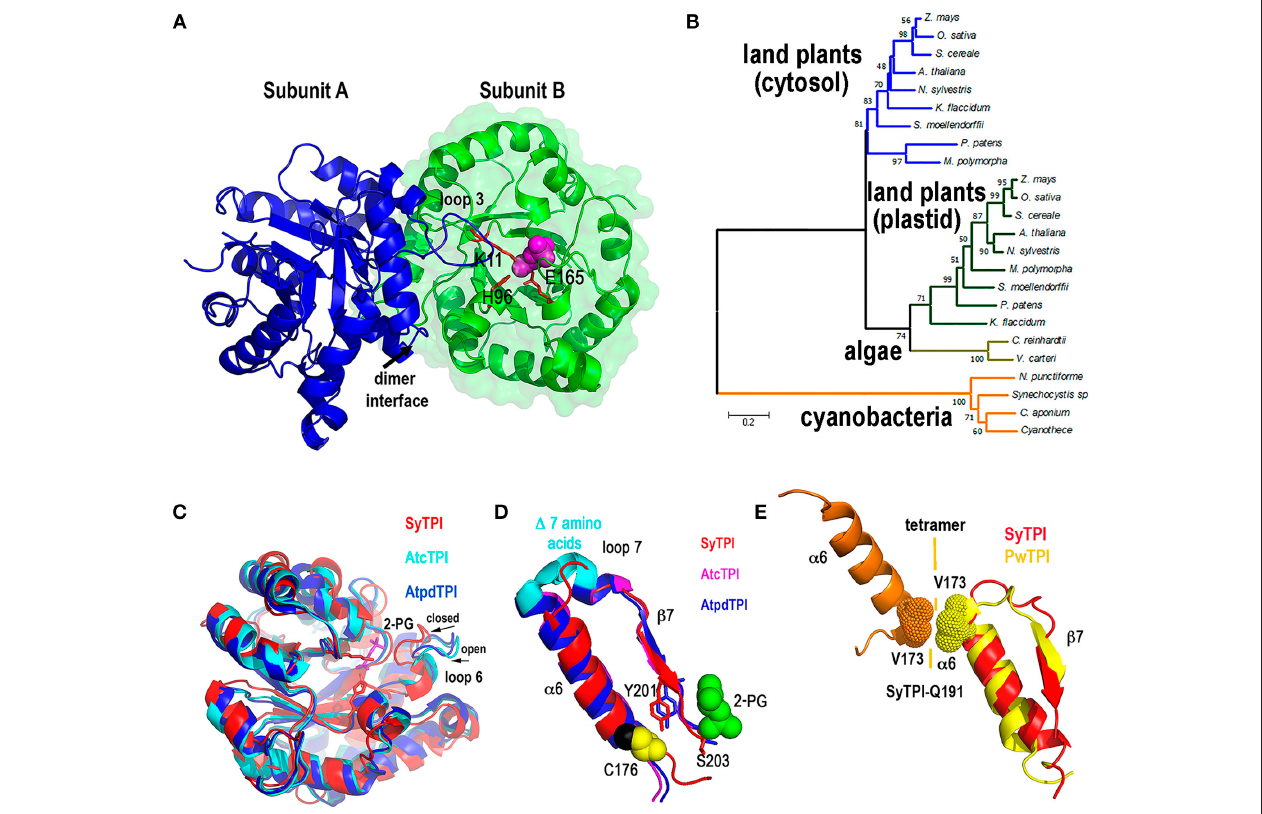
FIGURE 2 | Quaternary structure of SyTPI. (A) Cartoon representation of homodimeric SyTPI. The dimer interface is formed by the interconnection of loop 3, subunit A is colored in blue and subunit B is colored in green. 2-PG is colored pink in space-filled representation and the catalytic residues Lys11, His 96, and Glu165 are represented in a ball-stick representation. (B) Phylogenetic tree of TPIs from photosynthetic organisms. The tree consists of representative amino acid sequences of TPIs from land plants, green algae, and cyanobacteria, highlighting those TPIs with known crystal structure [ A. thaliana (cytosolic and plastidic), C. reinhardtii , Synechocystis ]. Bootstrap values are reported at nodes. The distance scale is indicated between 0 and 1, where 0.2 indicates 20% differences between two sequences. (C) Superimposition of SyTPIs with AtcTPI and AtpdTPI. SyTPI is present in a closed loop 6 conformation. (D) Ribbon representation focus on α 6 and β 7 of SyTPI, AtcTPI, and AtpdTPI. AtcTPI and AtpdTPI connect α 6 and β 7 by means of a short α helix, whereas SyTPI presents a deletion of seven amino acids and connect these structural elements by a short loop. (E) Structural comparison between tetrameric TPI from Pyrococcus woesei (PDB: 1HG3) and SyTPI in the